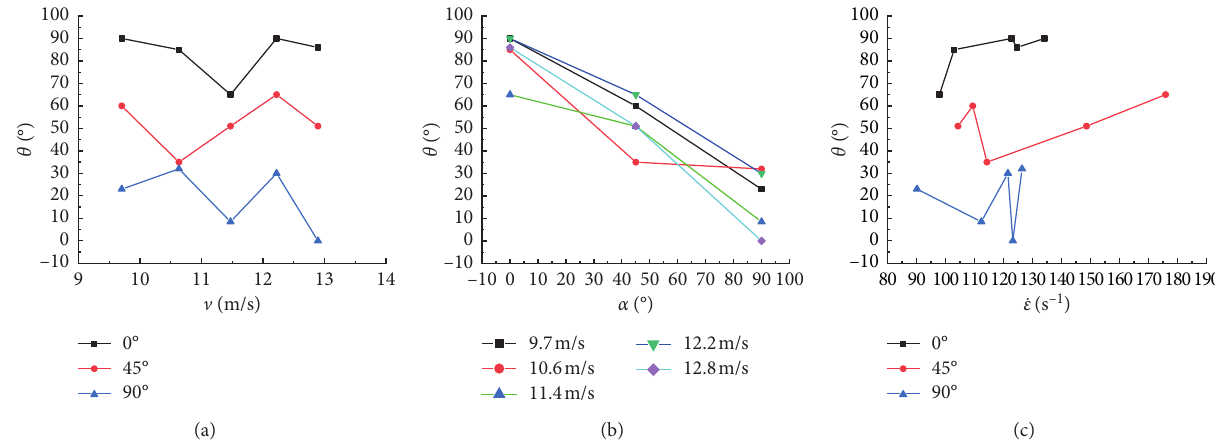
Figure 12: Relationship between crack initiation angle and loading rate, prefabricated fracture angle, and strain rate.